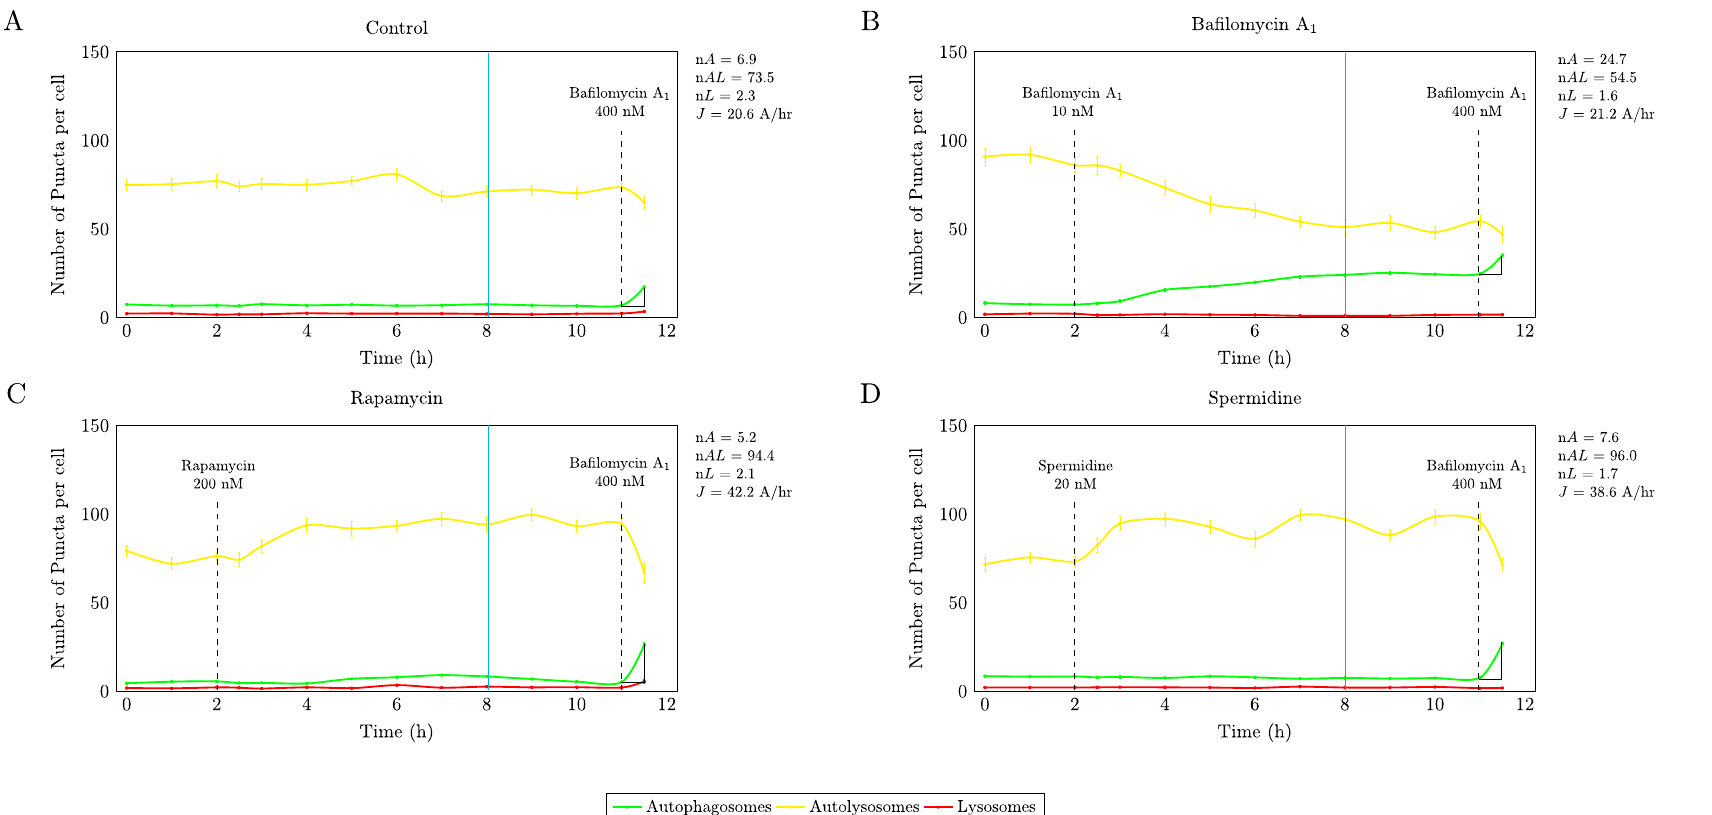
Figure 1. In order to assess autophagosome flux, the pathway intermediates were plotted in time. Flux response analysis using autophagy modulating drugs reveals a similarly enhanced autophagosome flux using 200 nM rapamycin ( C ) and 20 nM spermidine ( D ) compared to control conditions ( A ), with a new steady state flux established 6 h into the treatment time (blue vertical line). Note, low concentrations of bafilomycin lead to a change in pathway intermediate pool size ( B ), without impacting basal autophagosome flux. A total of 20 cells have been analysed.